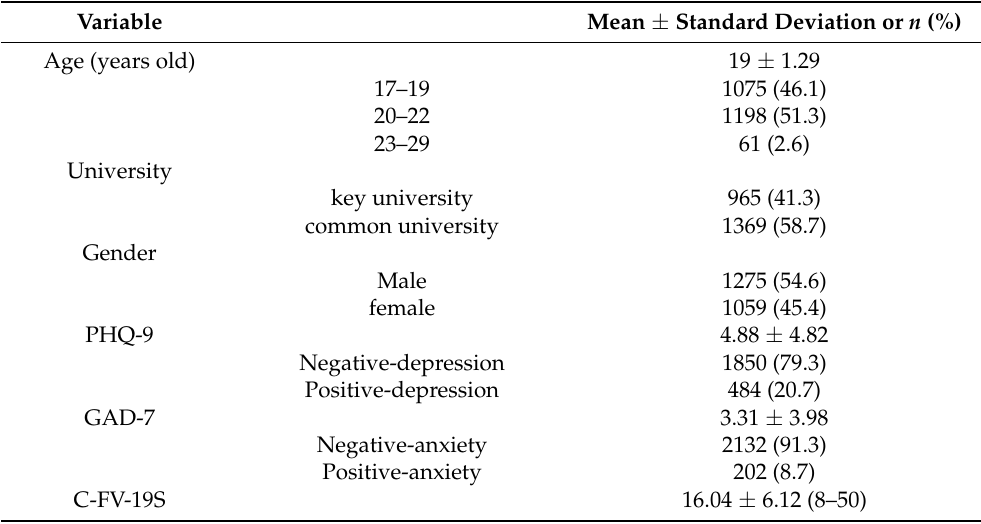
Table 1. Participant characteristics ( n =